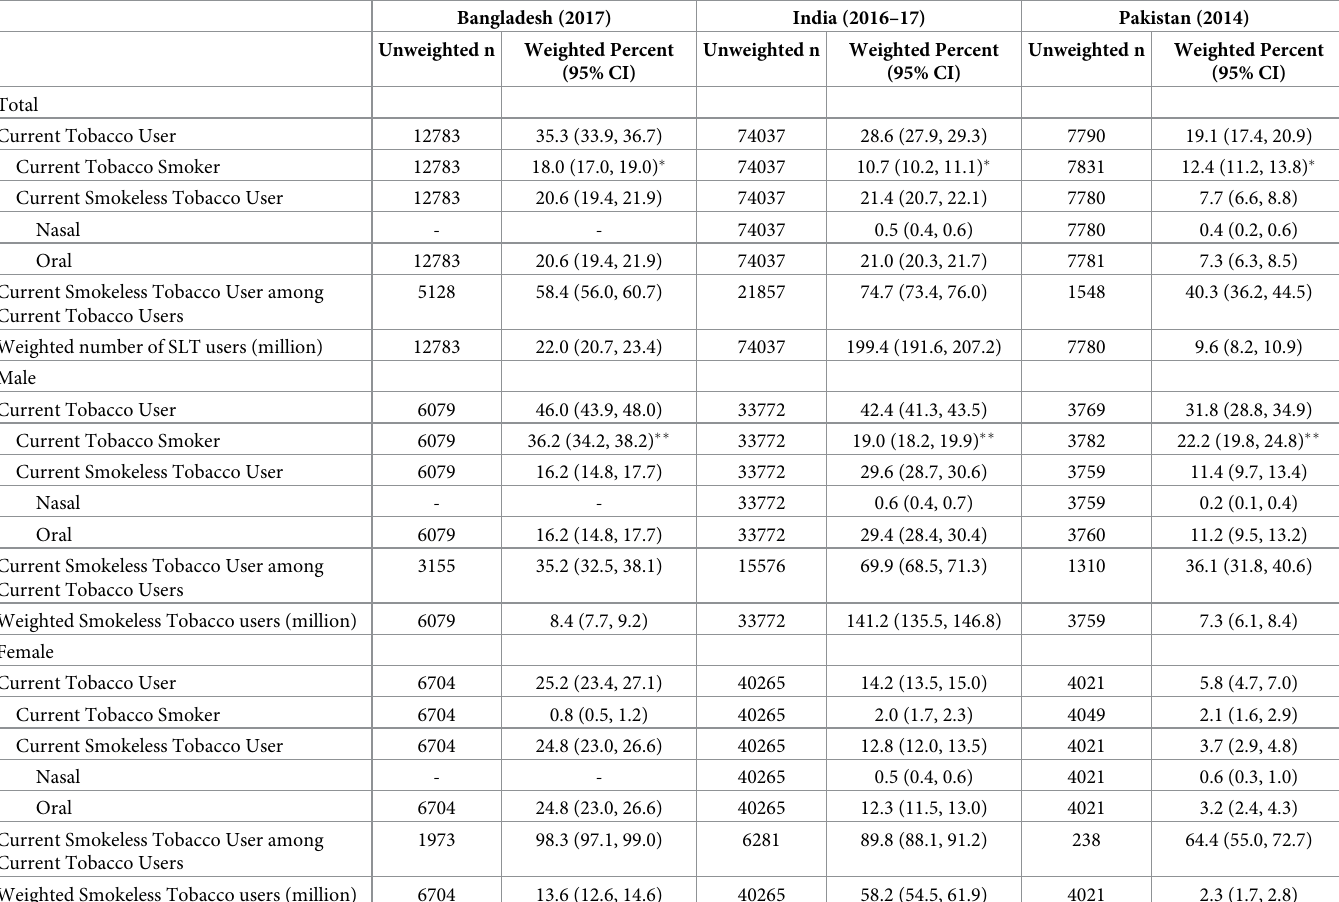
Table 1. Sample size, prevalence and type of tobacco used overall and by sex among adults aged 15 years or older in Bangladesh, India and Pakistan, GATS 2014–